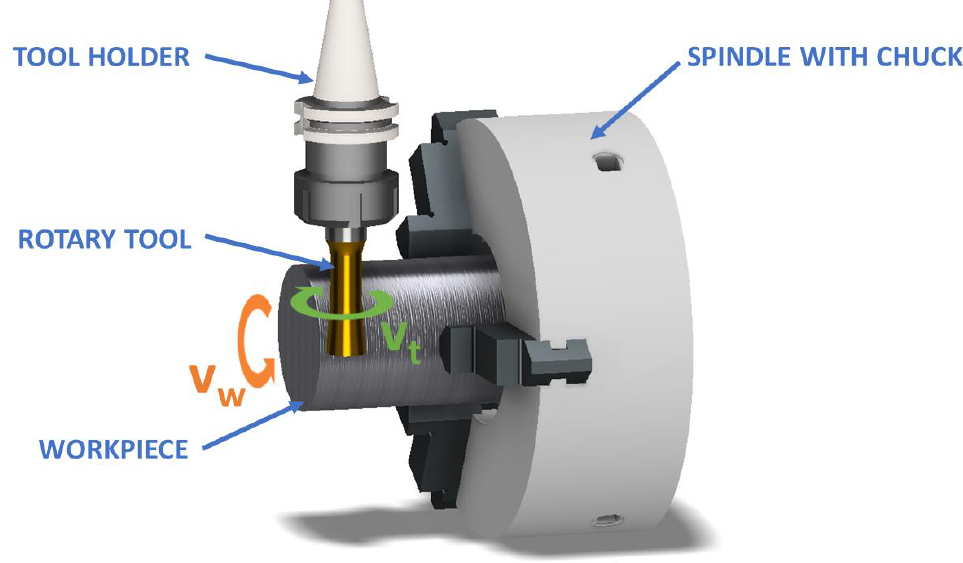
Figure 1. Scheme of actively driven rotation machining.